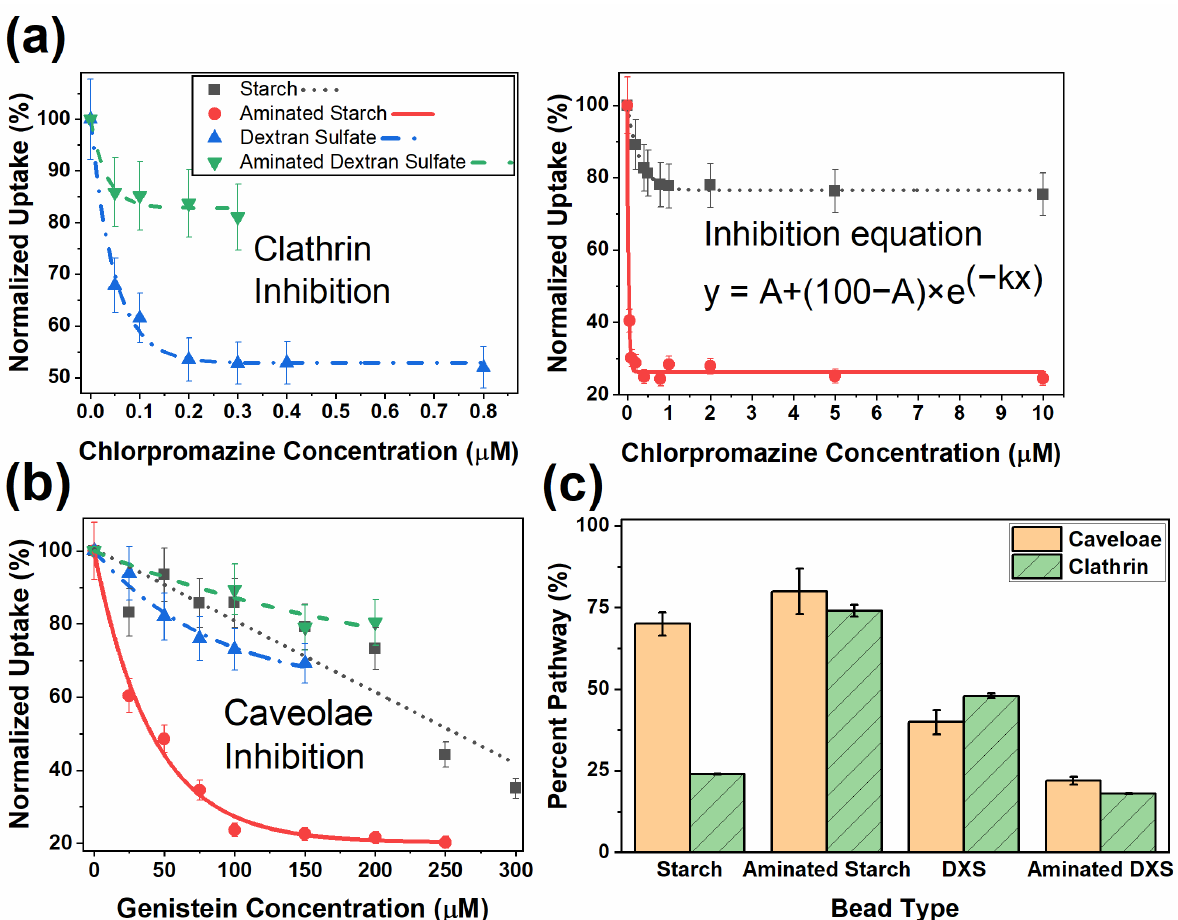
Figure 5. Pathways of ingestion. ( a ) Normalized uptake (beads ingested per cell expressed as percent of control) versus inhibitor concentration with Genistein to inhibit caveolae-dependent ingestion and ( b ) Chlorpromazine hydrochloride to inhibit clathrin-dependent ingestion of nanoparticles coated with starch, aminated starch, DXS, and aminated DXS. Standard deviation of all points is 7.8% of the mean (see Section 2.4). Data were fitted with the inhibition equation y = A + ((100 − A)exp( − kx)) except for starch beads with Genistein, which were fitted with a linear equation. k is toxicity (μM -1 ) and A is the plateau value, representing the uninhibited fraction of endocytosis events. ( c ) Percent uptake that is dependent on each pathway defined as (100 − A) for each bead coating.